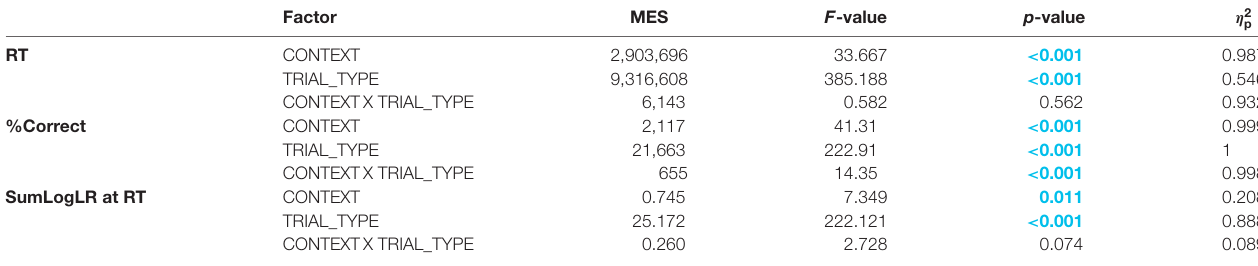
TABLE 1 | Inferential analyses of behavioral adaptations to the SAT context.